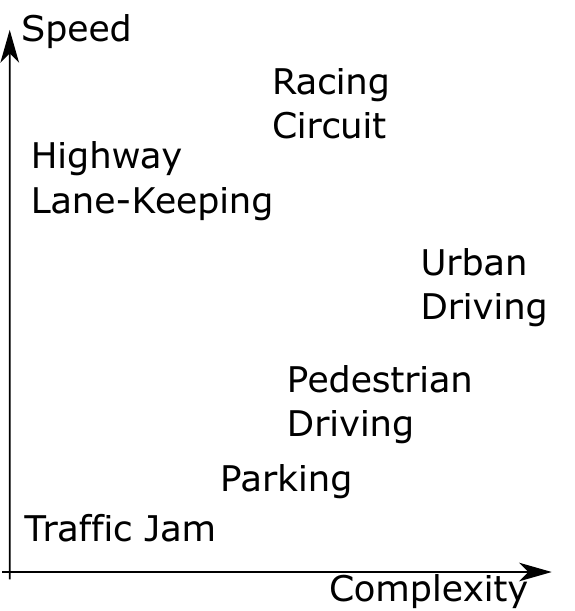
Figure 1. Complexity and operating velocity for various driving scenarios.